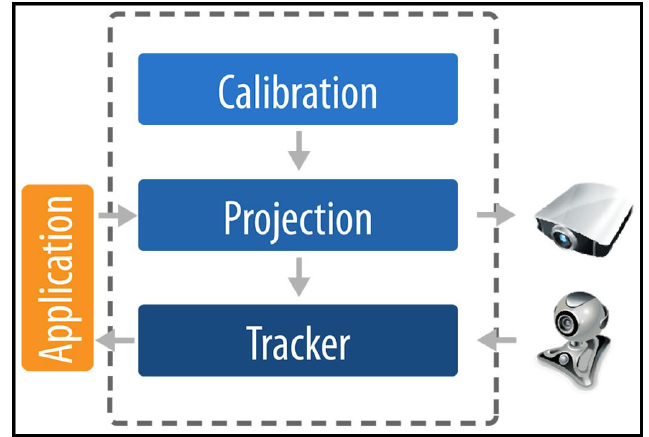
Fig. 4. ARBlocks architecture.